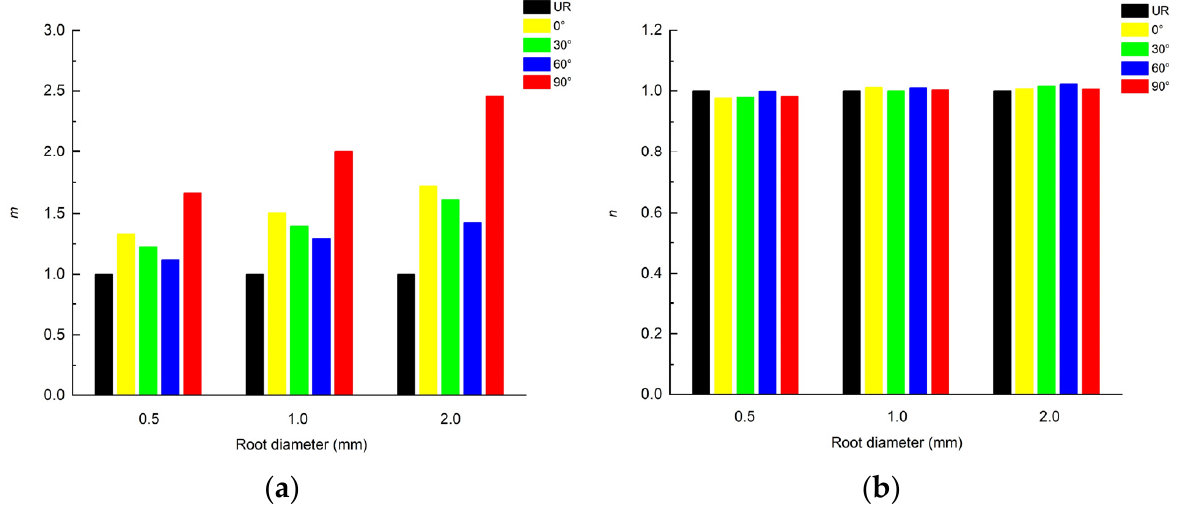
Figure 5. Variations of the soil root reinforcement coefficient under different conditions: ( a ) m , and ( b ) n . angle ( ∆ c (cid:48) and ∆ ϕ (cid:48) ) were both greater than zero, n and m were greater than 1.000.